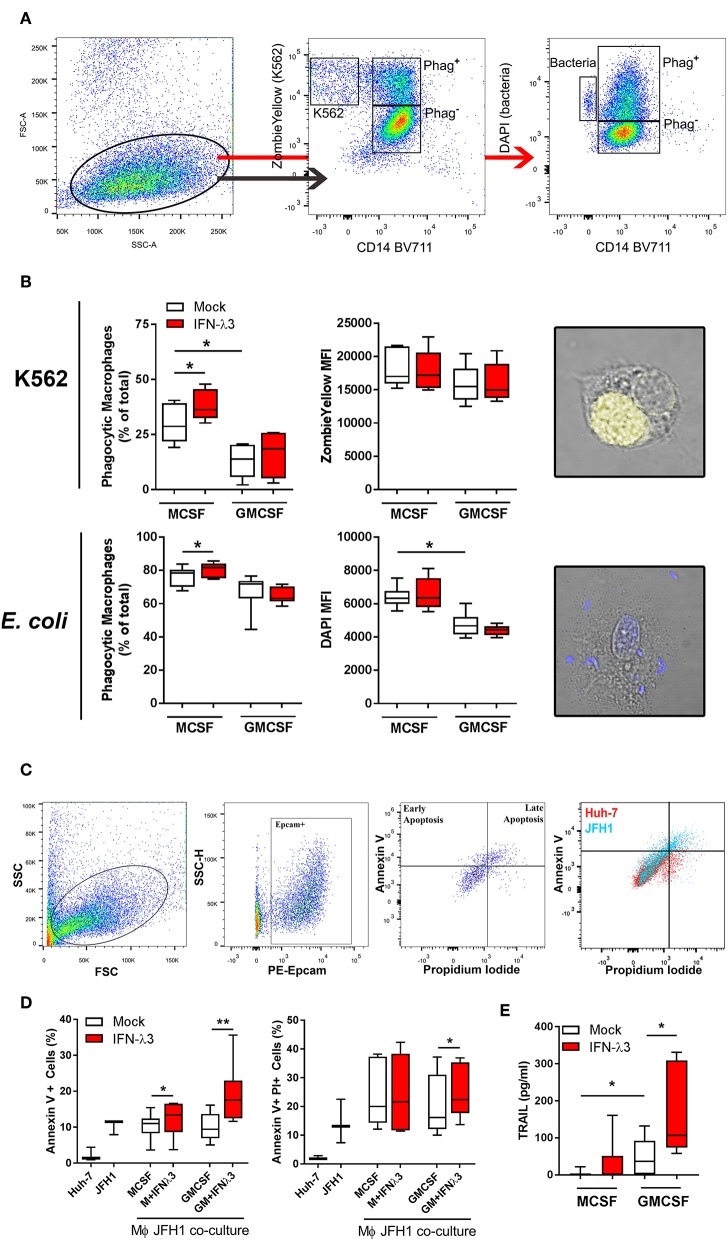
IFN-λ3 stimulates macrophage phagocytosis of apoptotic cells. To examine the role of IFN-λ3 on macrophage phagocytosis, apoptotic K562 cells or E. coli were added to Mϕ cultures for 1 h at a ratio of 2:1 and 4:1, respectively. Phagocytic Mϕs were defined as cells double fluorescent for CD14 (BV711), and ZombieYellow viability stain/DAPI, representing target cell engulfment (A). M-Mϕs were more phagocytic than GM-Mϕs toward K562 cells (2-fold increase, p < 0.05), a phenotype that was further increased by IFN-λ3 (B) (n = 6). Similarly, IFN-λ3 increased E. coli engulfment in M-Mϕs only. Mϕ MFI, representing the number of cells engulfed remained unchanged in response to IFN-λ3. To assess cytotoxicity toward virus infected cells, Mϕs were co-cultured with JFH1 infected Huh-7 cells, and apoptosis was quantified in Epcam+ Huh-7 cells using propidium iodide (PI) and Annexin V (C) (n = 7). IFN-λ3 stimulated GM-Mϕ cytotoxicity, increasing the percentage of early (Annexin V+) and late (Annexin V+, PI+) apoptotic cells, whereas early apoptosis alone was affected in M-Mϕs (D). TRAIL expression was up-regulated by IFN-λ3 in GM-Mϕs only, providing a possible mechanism of cytotoxicity (E). Data are representative of two independent experiments. Wilcoxon matched pairs signed rank test (B,E), paired t-test (D) *p < 0.05, **p < 0.01 (mean ± SE).